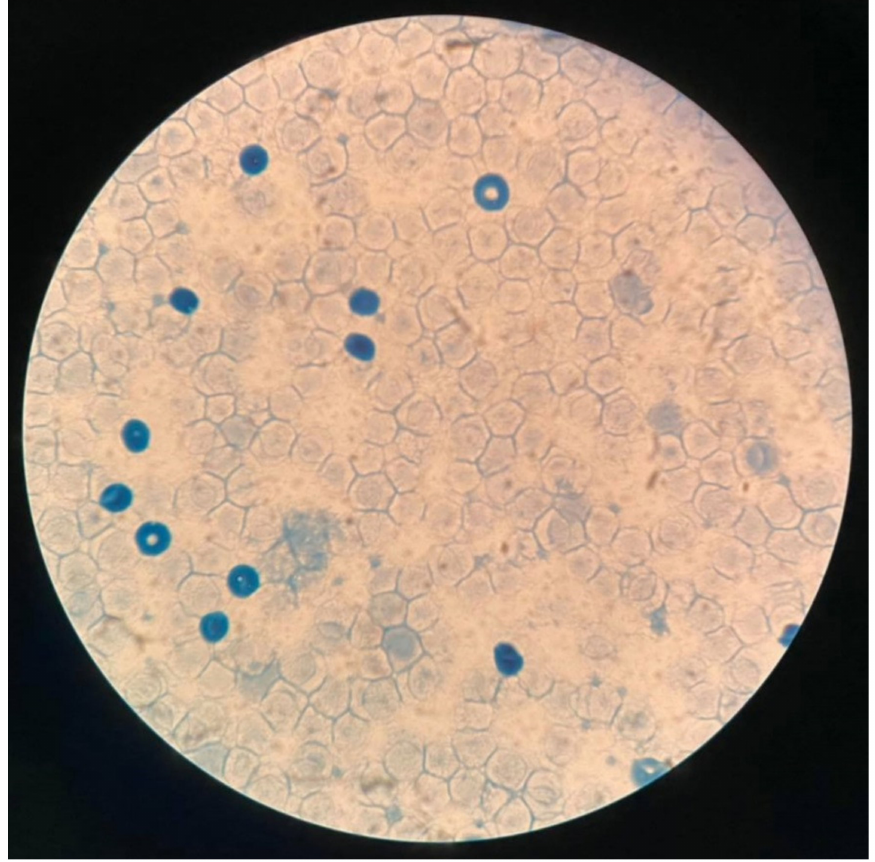
Figure 3. Acid-elution test shows numerous fetal cells (dark staining) in maternal circulation.